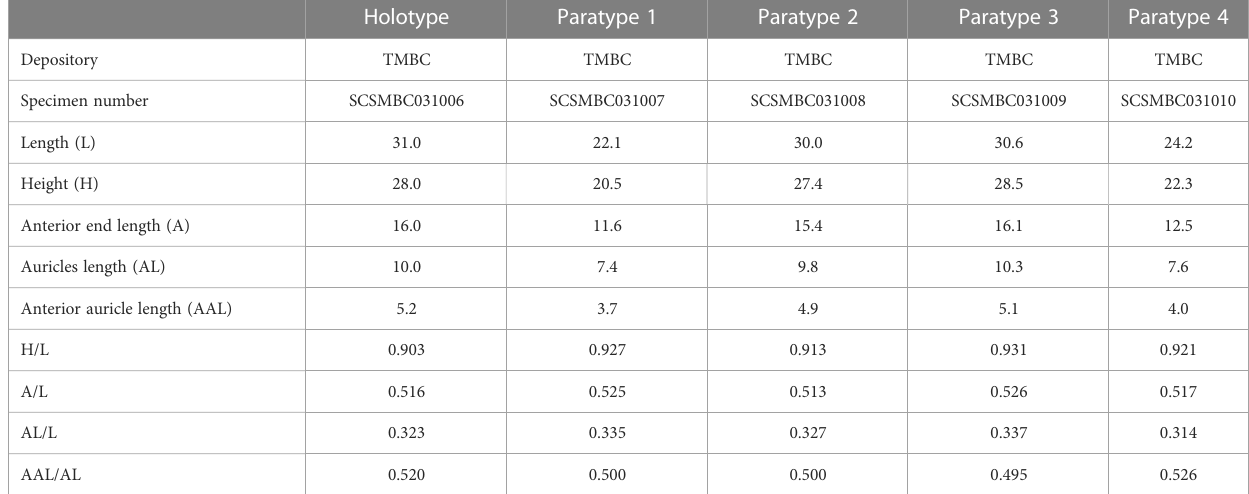
TABLE 2 Shell measurements (mm) and ratios of Catillopecten margaritatus n. sp.